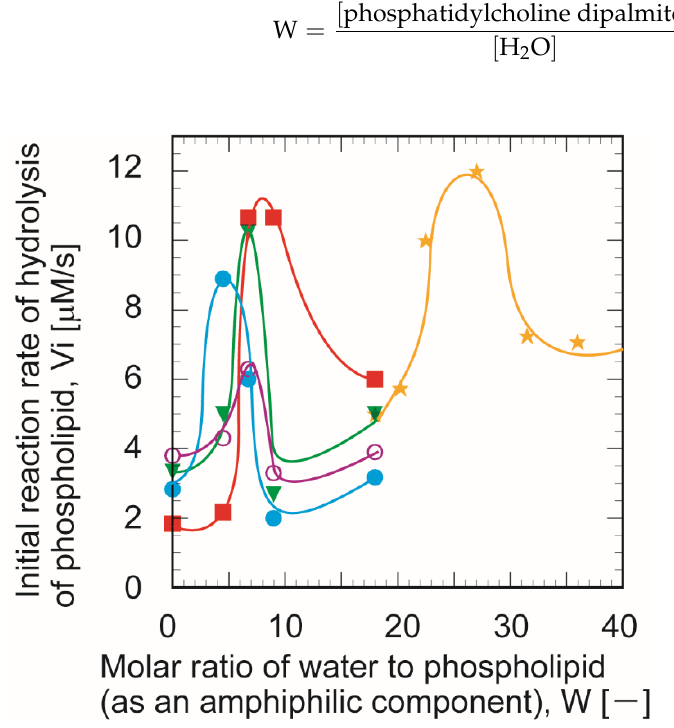
Figure 9. Effect of the water content on the initial reaction rate (Vi) in immobilized phospholipase A 1 . W/O microemulsion system with non-immobilized phospholipase A 1 was chosen as a reference ( ★ ). The glutaraldehyde concentration, C GA was 1.5% ( ● ), 3% ( ○ ), 6% ( ▼ ), and 10% ( ■ ). The experiments were each conducted a minimum of three times.